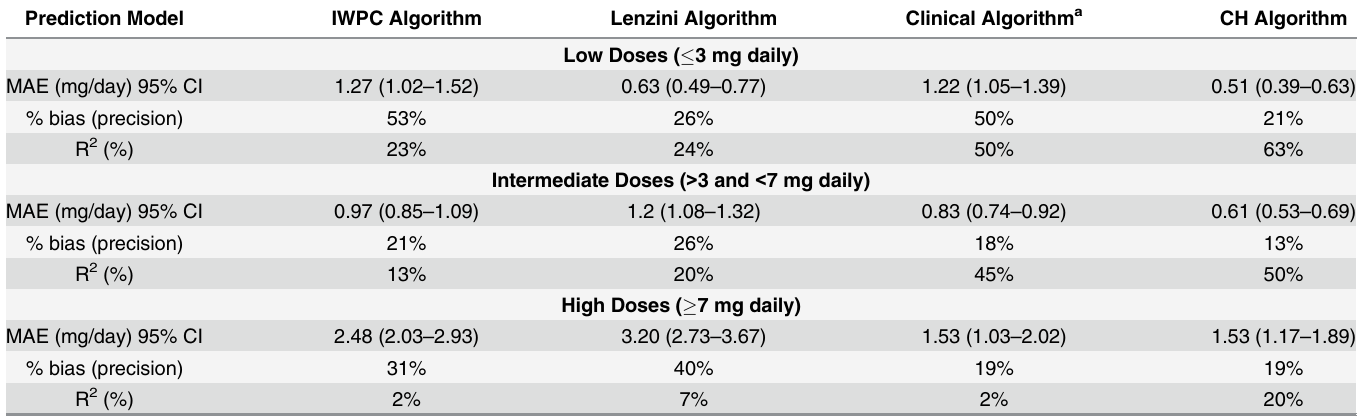
MAE stands for mean absolute error. The 95% con fi dence intervals (CIs) on the estimates of MAE were calculated.